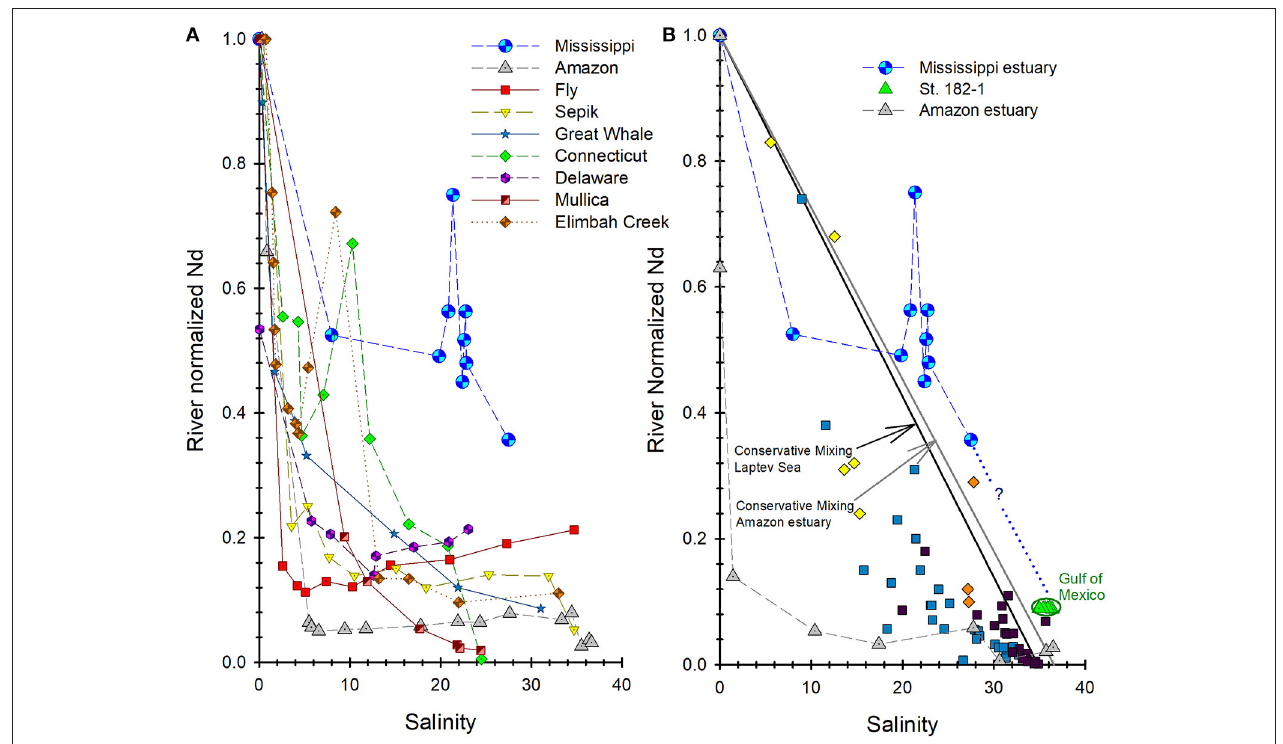
FIGURE 4 | River water-normalized Nd concentrations through the Mississippi River (MR) estuary (locations from Figure 1 ; this study) compared to other river/estuarine systems. (A) Compares the MR estuary to estuarine systems reviewed in Rousseau et al. (2015). (B) Compares the MR estuary’s “conservative mixing” with station 182-1 in Osborne et al. (2015) to river/estuarine systems of the Laptev Sea (Figure 8a in Laukert et al., 2017), and the Amazon River estuary (Rousseau et al., 2015 ).